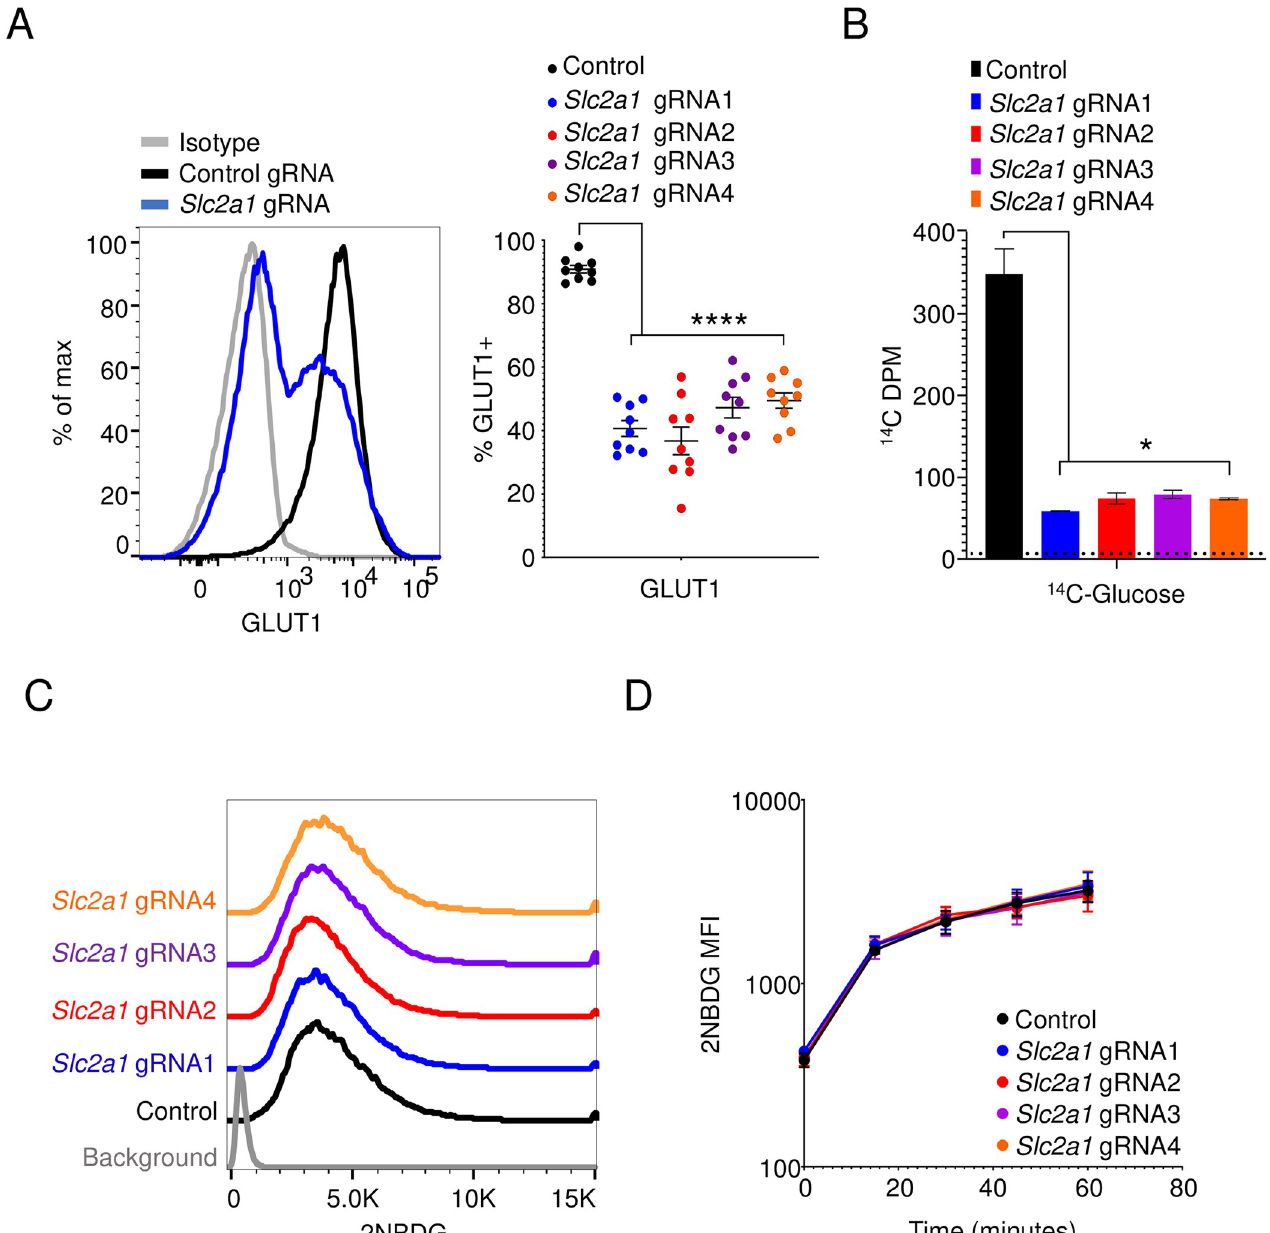
Fig 1. 2NBDG uptake is unaffected by Slc2a1 deletion in 5TGM1 cells. (A) GLUT1 staining of gRNA-transduced cells. Representative histogram (left) showing GLUT1 expression on 5TGM1 cells transduced with a control gRNA (black) and a Slc2a1 -targeting gRNA (blue). Quantification of percent GLUT1 positive cells (right) in control and Slc2a1 gRNA-transduced cells across 9 independent experiments. Each circle represents a single group from a single experiment. ��� p < 0.0001 by Brown-Forsyth and Welch one-way ANOVA multiple comparisons test. (B) 14 C-glucose uptake in gRNA-transduced cells. Lysates from cells transduced with gRNAs as in (A) were cultured in 14 C-glucose containing media for 30 minutes and 14 C signal was quantified in the cell pellet. Background counts indicated by the dotted line. Representative graph of three independent experiments. � p < 0.05 by Brown-Forsyth and Welch one- way ANOVA multiple comparisons test. (C) Flow cytometric analysis of 2NBDG uptake in control gRNA- (black) and Slc2a1 gRNA-transduced (colored) 5TGM1-Cas9 cells. Cells were cultured in media containing 2NBDG for 60 minutes. Histogram representative of three independent experiments. (D) 2NBDG uptake in control gRNA (black) and Slc2a1 gRNA-transduced (colored) 5TGM1-Cas9 cells. Mean fluorescence intensity (MFI) +/- SEM shown for 0-, 15-, 30-, 45-, and 60-minutes post culturing with 2NBDG. Pooled data from three independent experiments. No significant differences were observed with ordinary two-way ANOVA with Dunnett’s multiple comparison